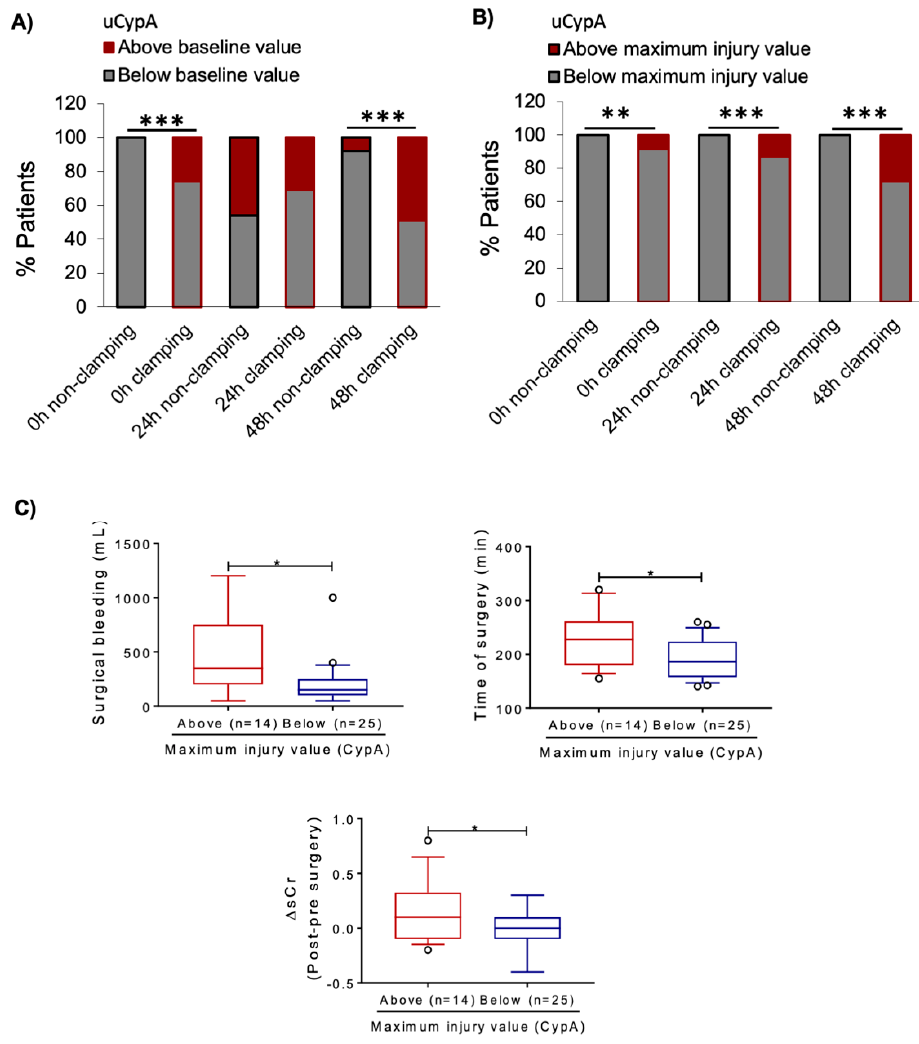
Figure 6. Percentage of patients with high uCypA levels after NSS using two different uCypA cut-off levels to define “high uCypA”. ( A ) Percentage of patients with post-surgery uCypA values above the highest pre-surgery uCypA value, found in the study population, i.e., >25 ng/mg; *** p < 0.001. ( B ) Percentage of patients with post-surgery uCypA values above the highest post-surgery uCypA values obtained in NSS without clamping, i.e., >100 ng/mg; ** p < 0.01, *** p < 0.001. ( C ) Time of surgery, surgical bleeding and increase in sCr are higher in clamping patients with CypA above maximum injury levels. Data are presented as box plots that show the mean, 25/75 percentiles (box), and 10/90 percentiles (bars). * p < 0.05.